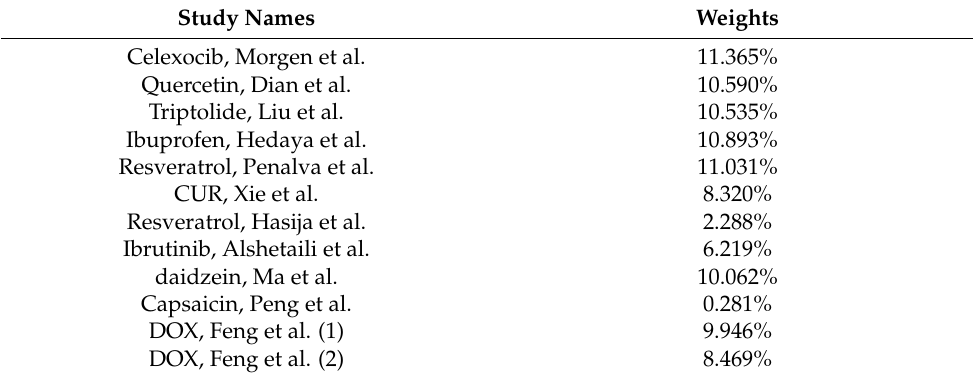
Table 2. Weights of the investigated studies.